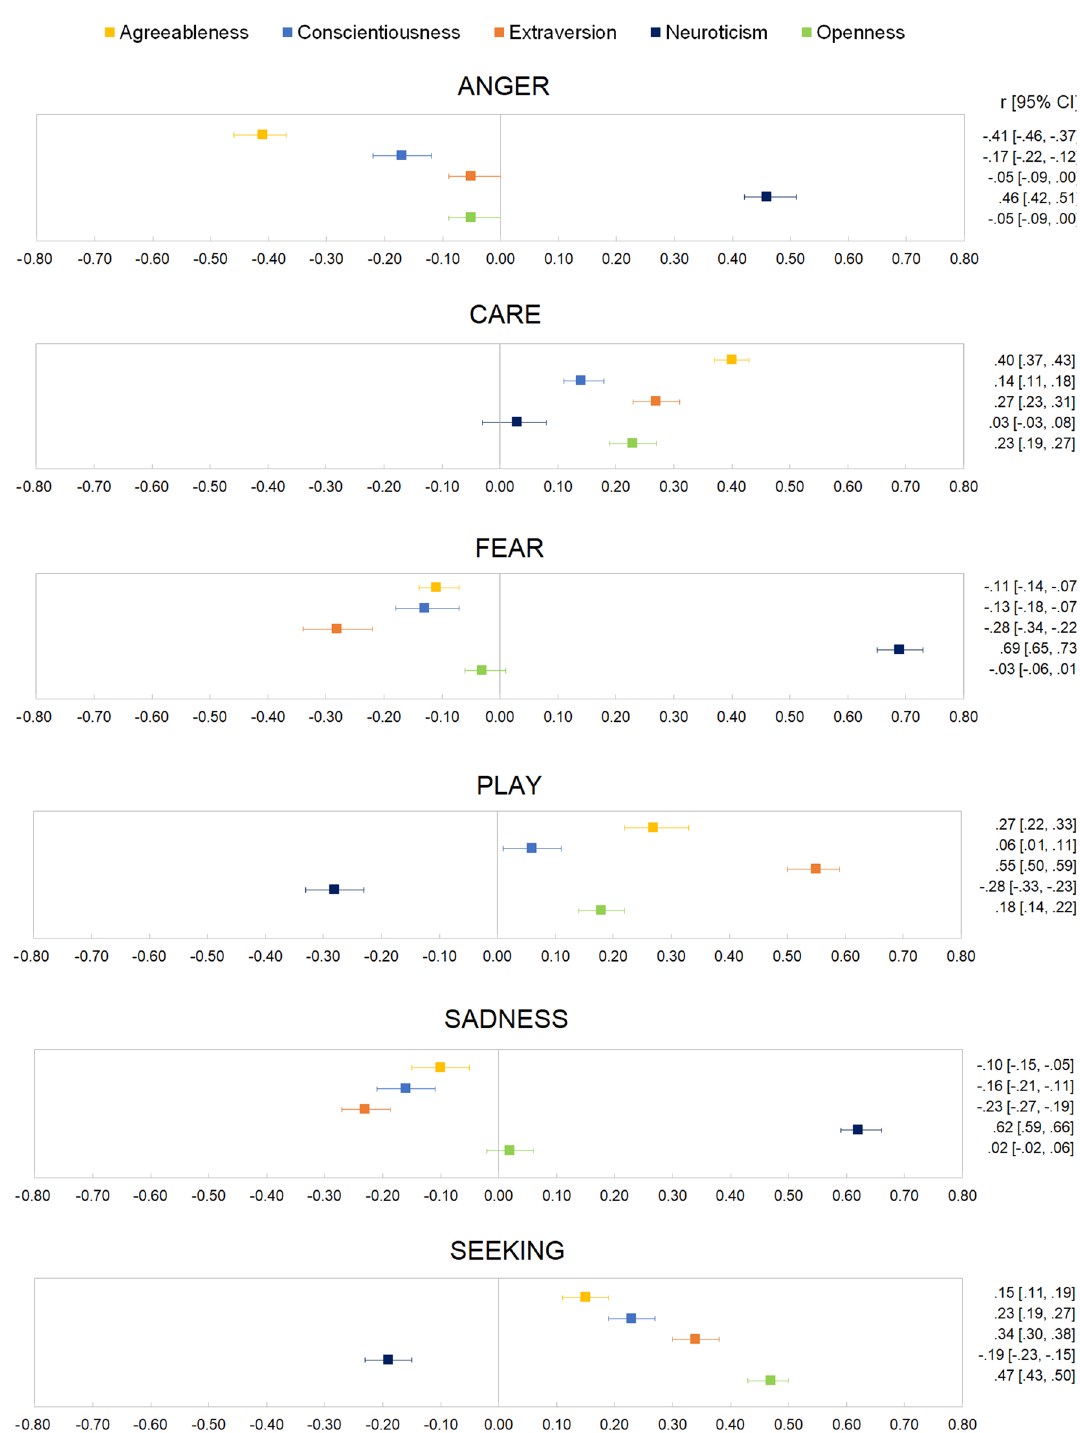
Figure 2. Forest-plots of meta-analytic correlations between ANPS and Big Five Personality